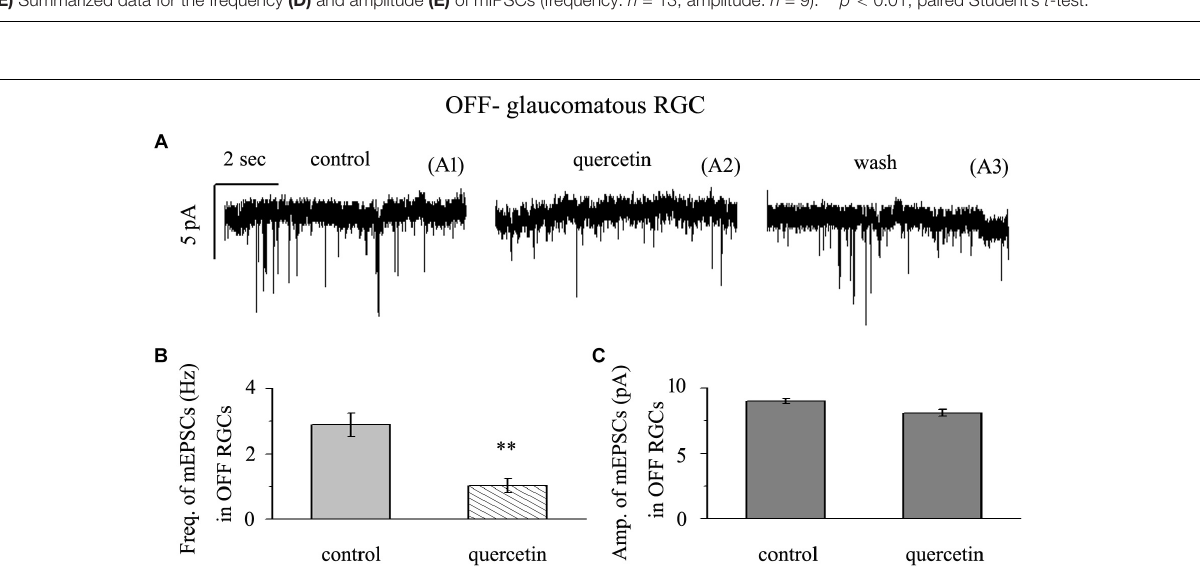
FIGURE 6 | Quercetin significantly inhibited the frequency, but not the amplitude, of mEPSCs in OFF-type RGCs. (A) Representative traces showing the effect of 10 µ M quercetin on glutamatergic mEPSCs in OFF-type RGCs. (A1) Control conditions; (A2) during quercetin treatment; (A3) recovery. Vertical bar, 5 pA; horizontal bar, 2 s. (B) Summarized data from 14 OFF-type RGCs showing that 10 µ M quercetin significantly decreased the average frequency of glutamatergic mEPSCs. (C) Summarized data from 14 OFF-type RGCs showing that 10 µ M quercetin did not change the average amplitude of glutamatergic mEPSCs. ∗∗ p < 0.01, paired Student’s t